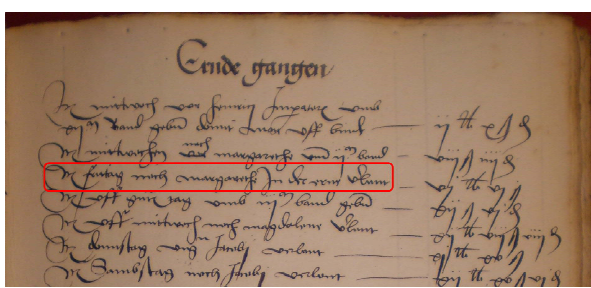
Fig. 4. “Item fritag nach margarethe in der ernt verlont” ,,also remunerated in harvesting (work) on Friday after Margaret (Day)” Extract form the book of expenditures of the hospital of Basel (from 1522); Staatsarchiv Basel- Stadt; Spital F12 (source 1).